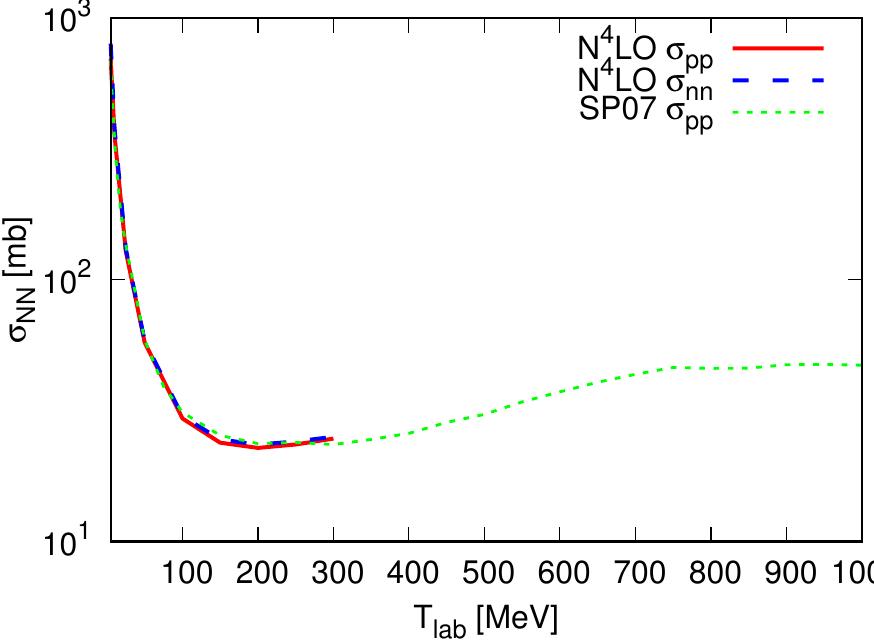
Figure 5 . Total pp (solid) and nn (dashed) elastic scattering cross sections as a function of the lab kinetic energy T lab , from the N 4 LO chiral e(cid:11)ective (cid:12)eld theory results for the phase shifts presented in ref. [47]. Also plotted is the SP07 global (cid:12)ts for the total pp elastic cross section (dotted) reported in ref.